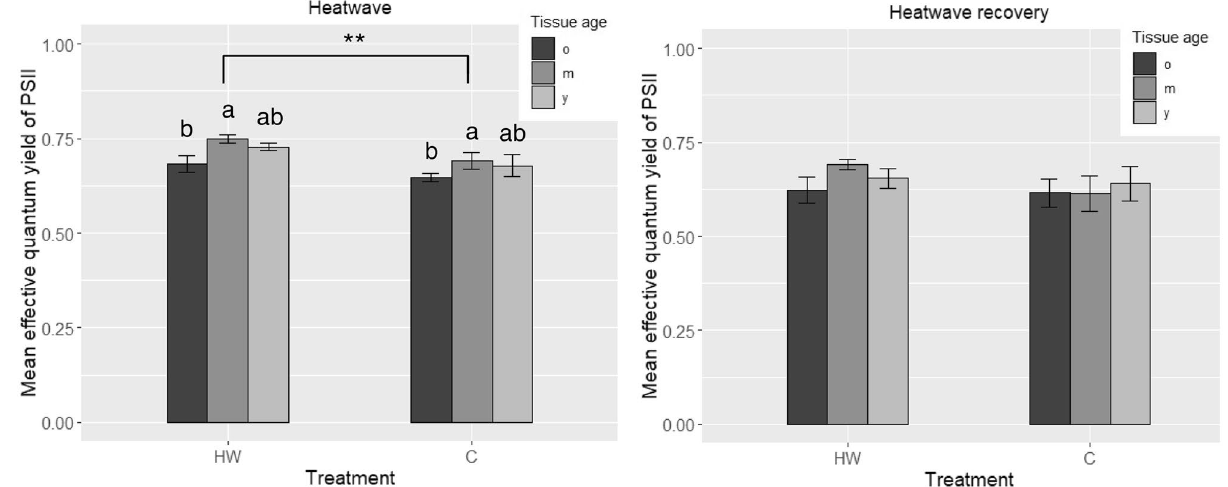
Figure 3. Effective quantume yield of PSII (Φ PSII ) of C. nodosa ’s leaf tissues. Old (o), mature (m) and young (y) leaf tissues were sampled from shoots cultivated in heatwave (HW) and control (C) conditions, both during the heatwave and after heatwave recovery. Values are mean ± SE ( n = 5 ). Different letters indicate significant differences between tissue ages ( p < 0.05), and ** indicates significant differences between treatments HW and C ( p <